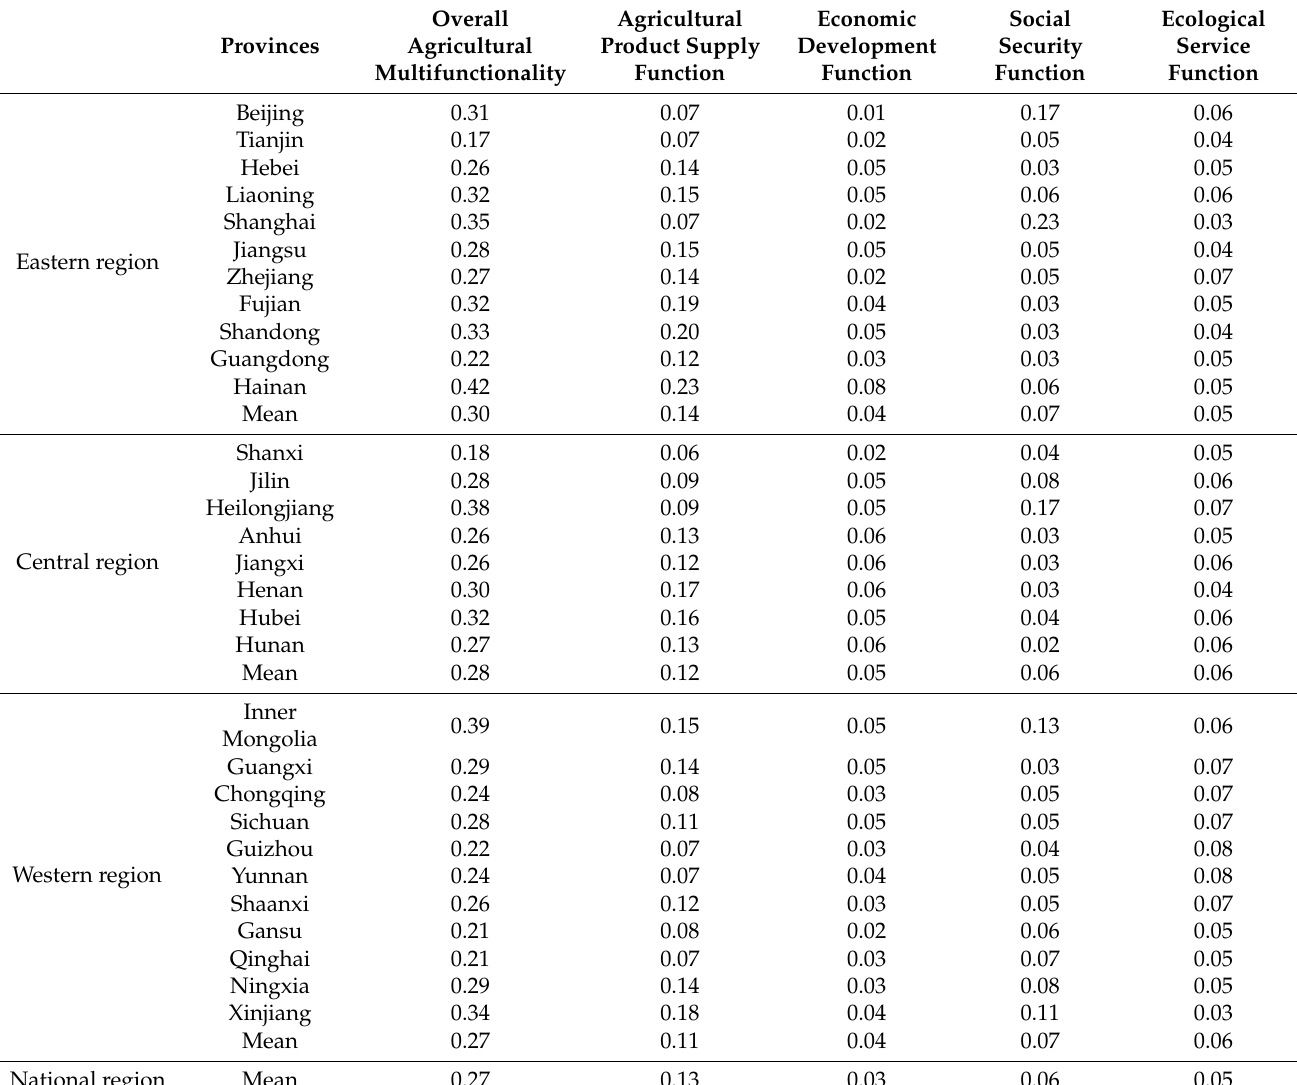
Table 4. Average values of agricultural multifunctionality, and subdivision indices of 30 sample provinces in China from 2011 to